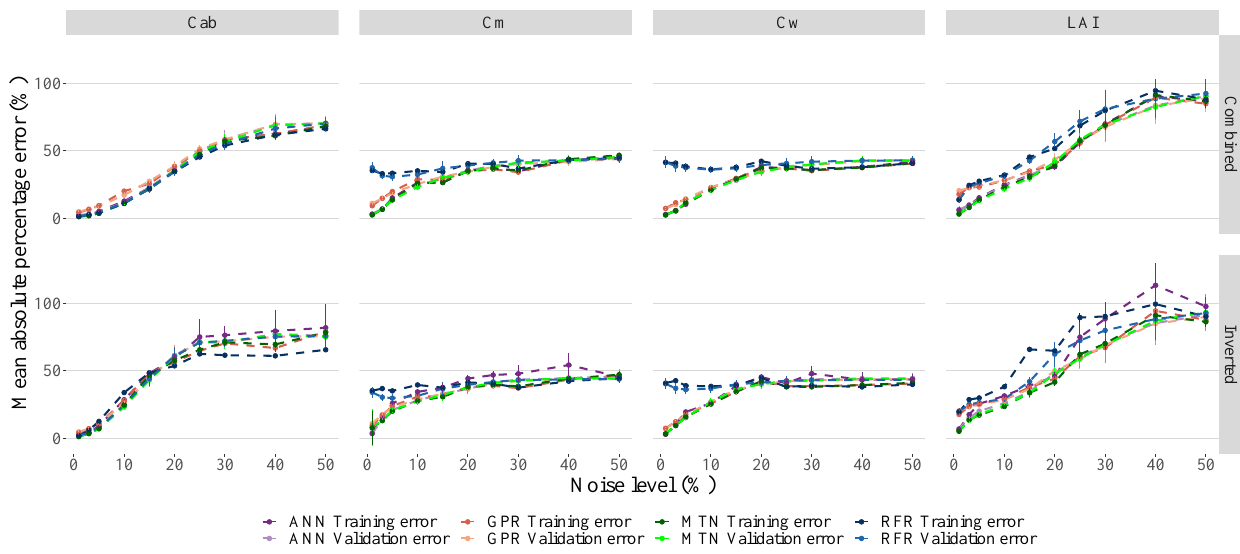
Figure 8. Effect of noise on model performance. While each model has its own color, the darker colors represent the training error. The data used for these plots is accessible in the Github repository provided at the end of this manuscript.